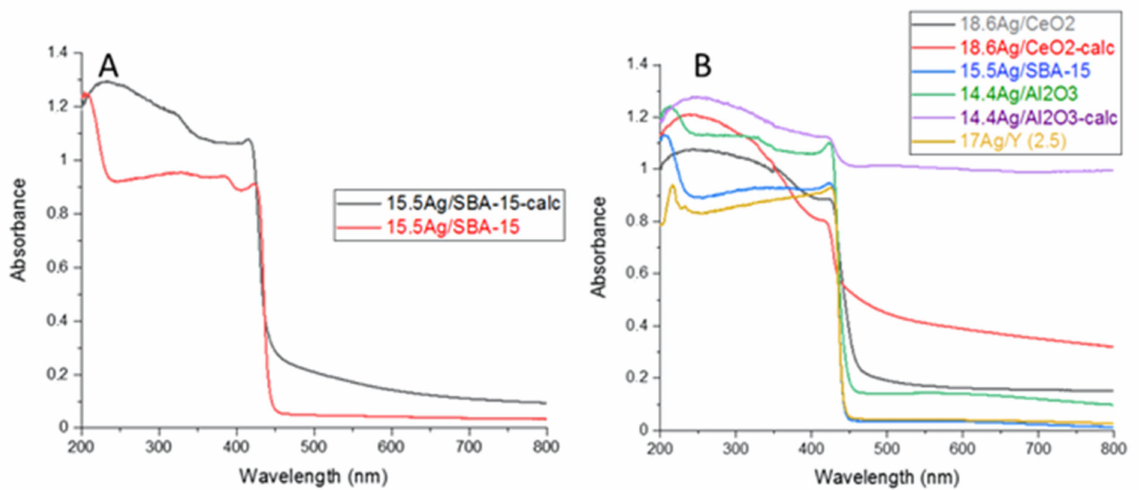
Figure 7. DR-UV-Vis spectra of some selected sorbents after I 2 ( A ) and CH 3 I ( B ) adsorption tests. On the other hand, and by comparing the spectrum of the non-calcined 15.5 Ag/SBA- 15 sample (Figure 7A), red) with the initial material not exposed to iodine (Figure 2, blue), it seems that some Ag + cations remained unaltered. For the calcined material (Figure 7A), black), the presence of a broad absorption at wavelengths above the absorption edge wit- nesses of the presence of residual silver nanoparticles; however, it is in lower concentration compared with the unexposed material (Figure 2, red). Overall, these data could be linked to adsorption results, which have shown that the molar I/Ag ratio after I 2 tests remained below unity (0.86 and 0.94, respectively) for Ag/SBA-15 samples. Hence, it seems that some silver sites, probably deeply buried in the pores, could not be accessible to iodine and react to form AgI